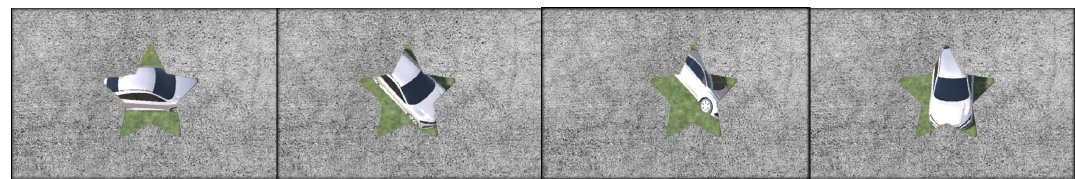
Figure 6. Erasure animations with a 3D scene